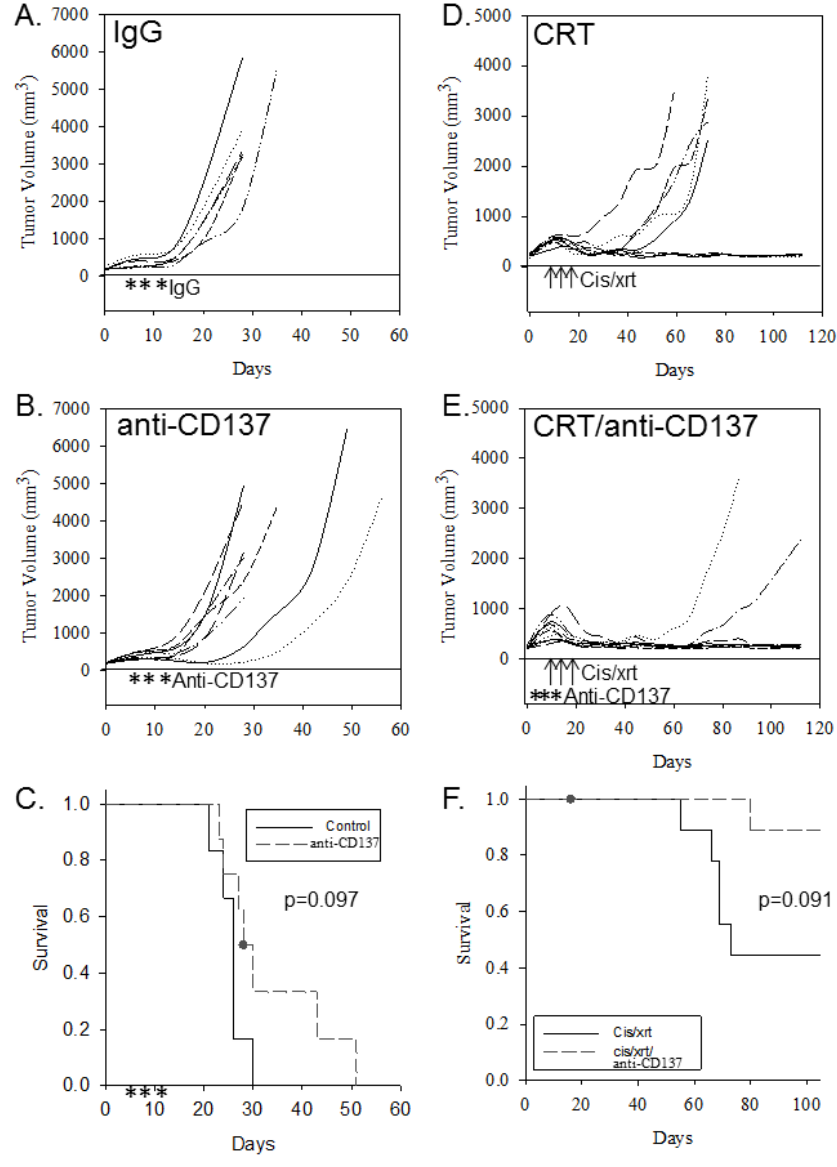
Figure 1. Activating anti-CD137 antibody administered in conjunction with standard-of-care treatment further inhibits tumor growth. Tumor growth curves (for individual mice) and group Kaplan-Meyer survival curves are shown for controls and for mice receiving